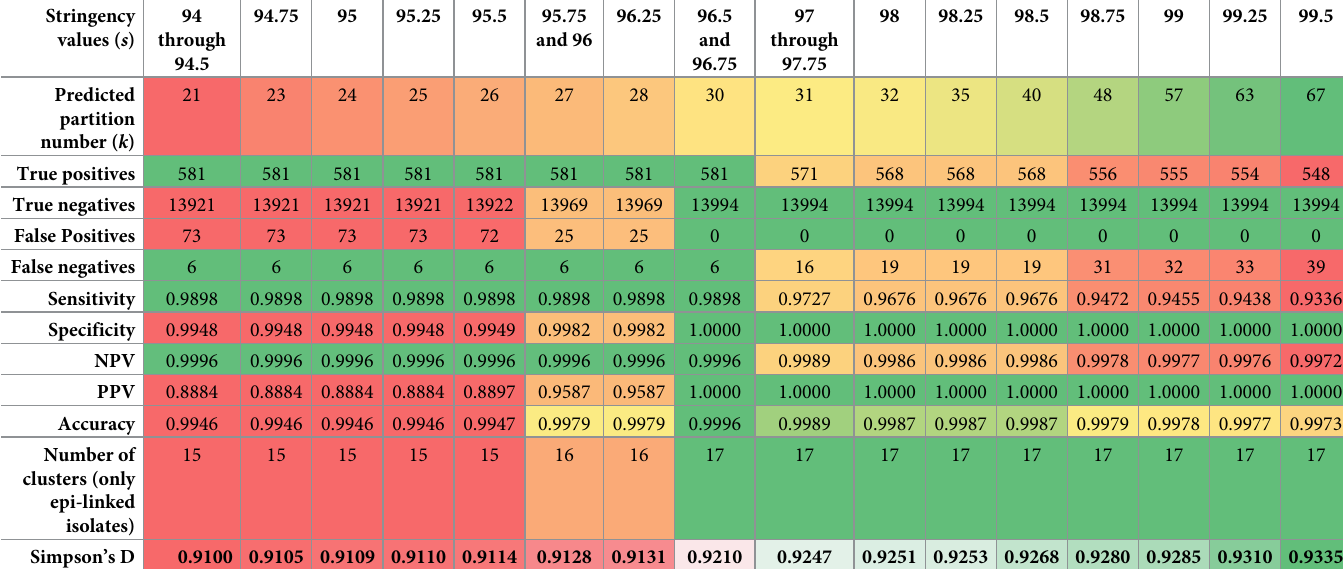
Cells color relates to optimal values, were red indicates values that are sub-optimal and dark green represents values that are optimal. Optimal s -values (those that maximize accuracy) are shaded in gray and surrounded by a dark box. a There were 26 epidemiologic clusters. Given that some outbreak clusters were caused by the same strain (Table 3), the epidemiologic clusters were distributed across